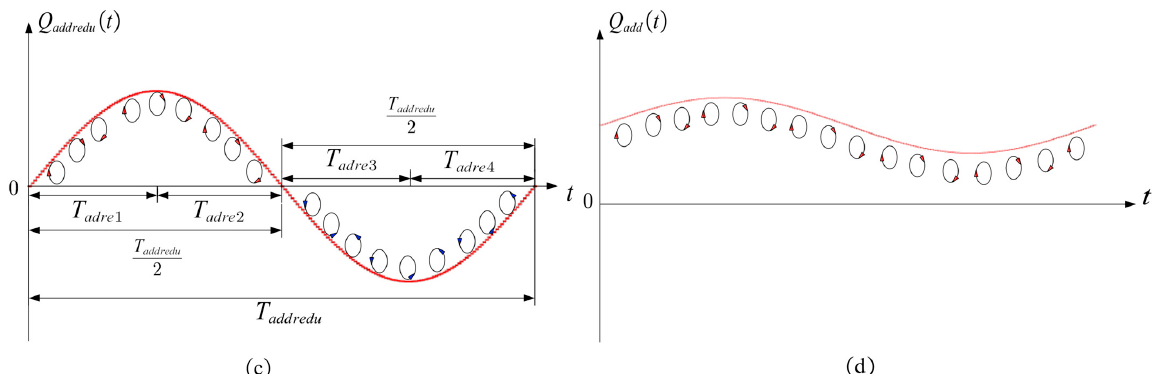
Figure 4. Schematic diagram of the elliptical coordinate system and determinant coordinate system: ( a ) schematic diagram of the elliptical coordinate system; ( b ) schematic diagram for the determining factors of the elliptical motion direction in T reduT ; ( c ) schematic diagram for the determining factors of the elliptical motion direction in T addreduT ; and ( d ) schematic diagram for the determining factors of the elliptical motion direction in T addT